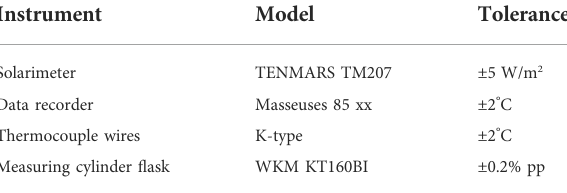
TABLE 1 Speci fi cation of the used